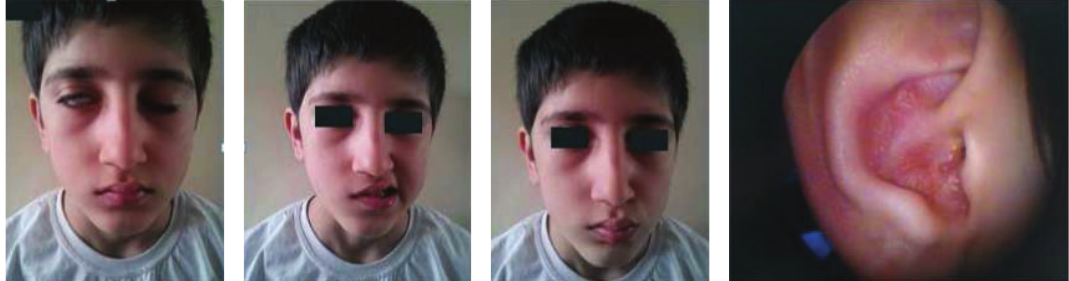
Figure 1: An 11-year-old male with right facial paralysis and vesicular lesions in the right auricula.